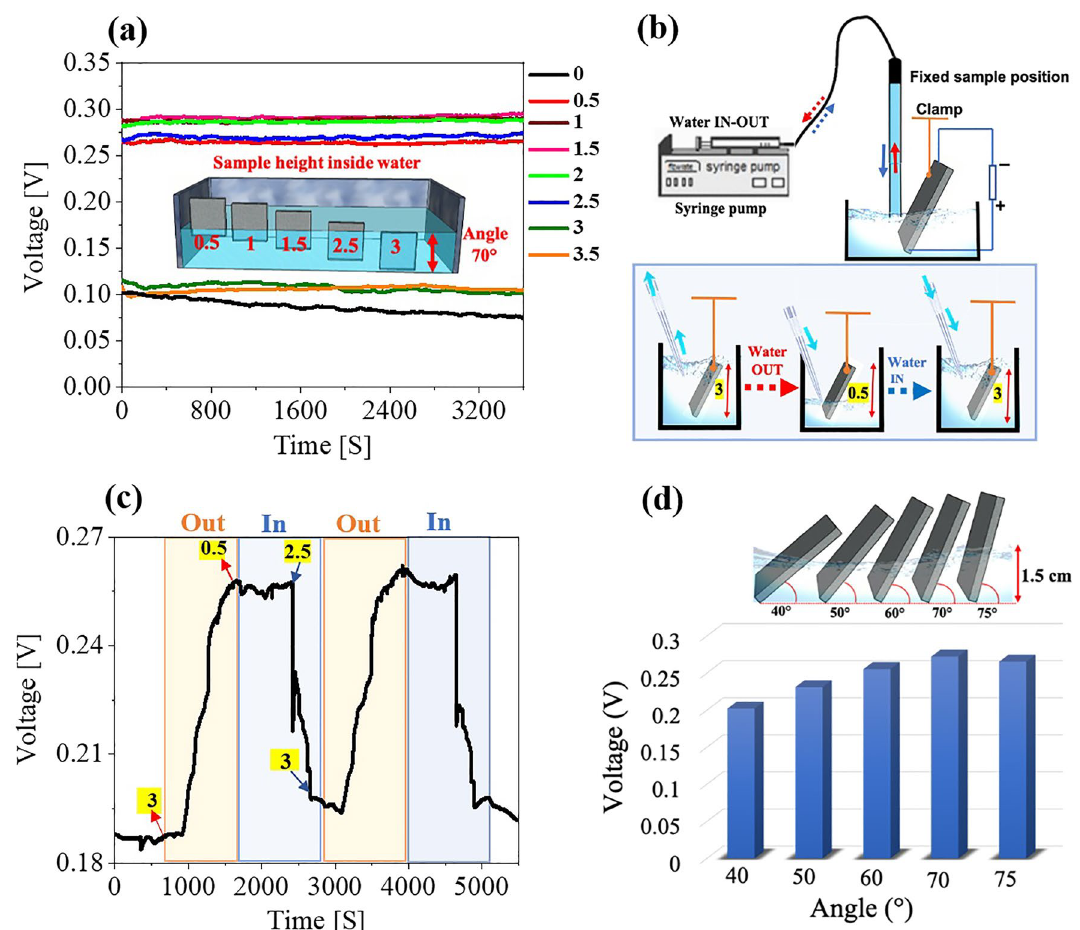
Figure 4. Voltage generation performance of alumina with ( a ) different sample heights inserted into the water, where the key shows different degrees (cm) of sample immersion in water and the inset schematic presents the amount of sample immersion in water at 70°. ( b ) Schematic representation of sample height (cm) in the water. ( c ) Dependence of the induced voltage difference on water transpiration speed. ( d ) Different sample placement angle at 1.5 cm sample height in